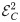
The stationary energy current J
2 as a function of the external magnetic flux Φe.Panel (a) for various temperatures of reservoirs: ({θ
1, θ
2} = {1, 10}, {1, 5}, {5, 10}. Panel (b) for EC2 = 0.1 and various Josephson energy: εJ = 8, 10, 12, 14. Panel (c) for εJ = 14 and various charging energy EC2 = 0.1, 0.15, 0.225, 0.25.